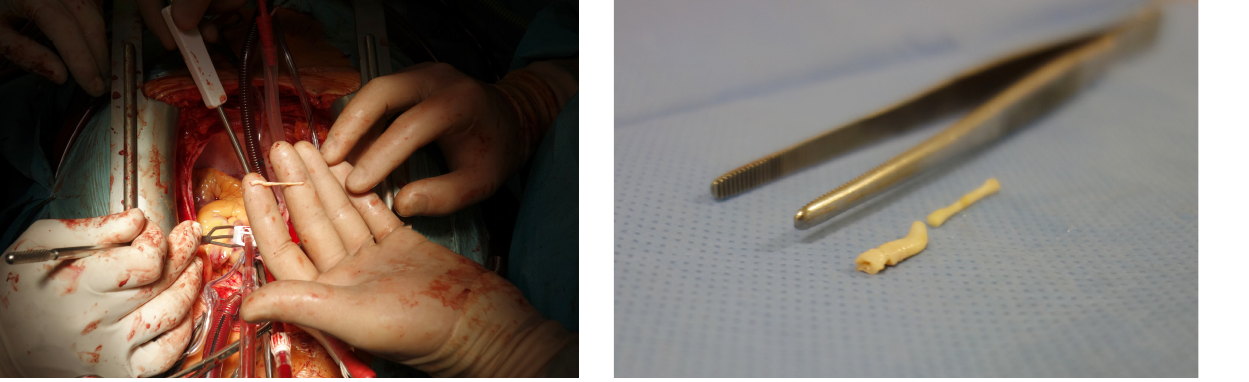
Fig. 6. Cardiac surgery. A fibrous chord-like material extirpated from the left atrium.